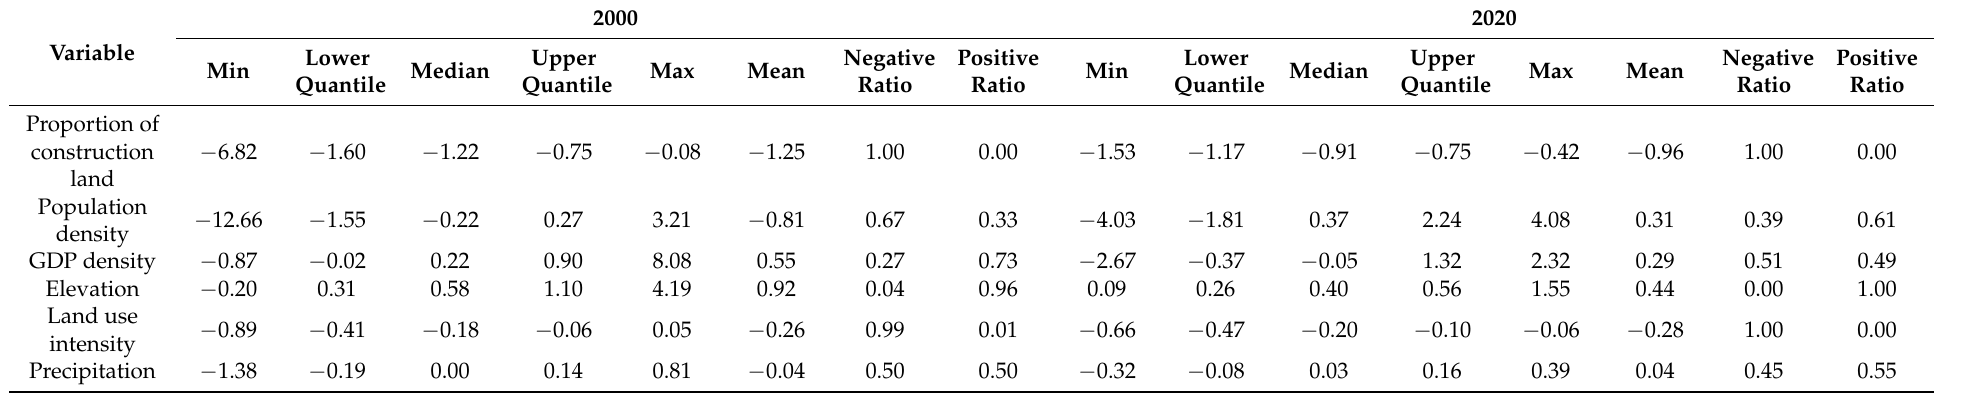
Table 5. Statistical results of the GWR model coefficient at the 10 km